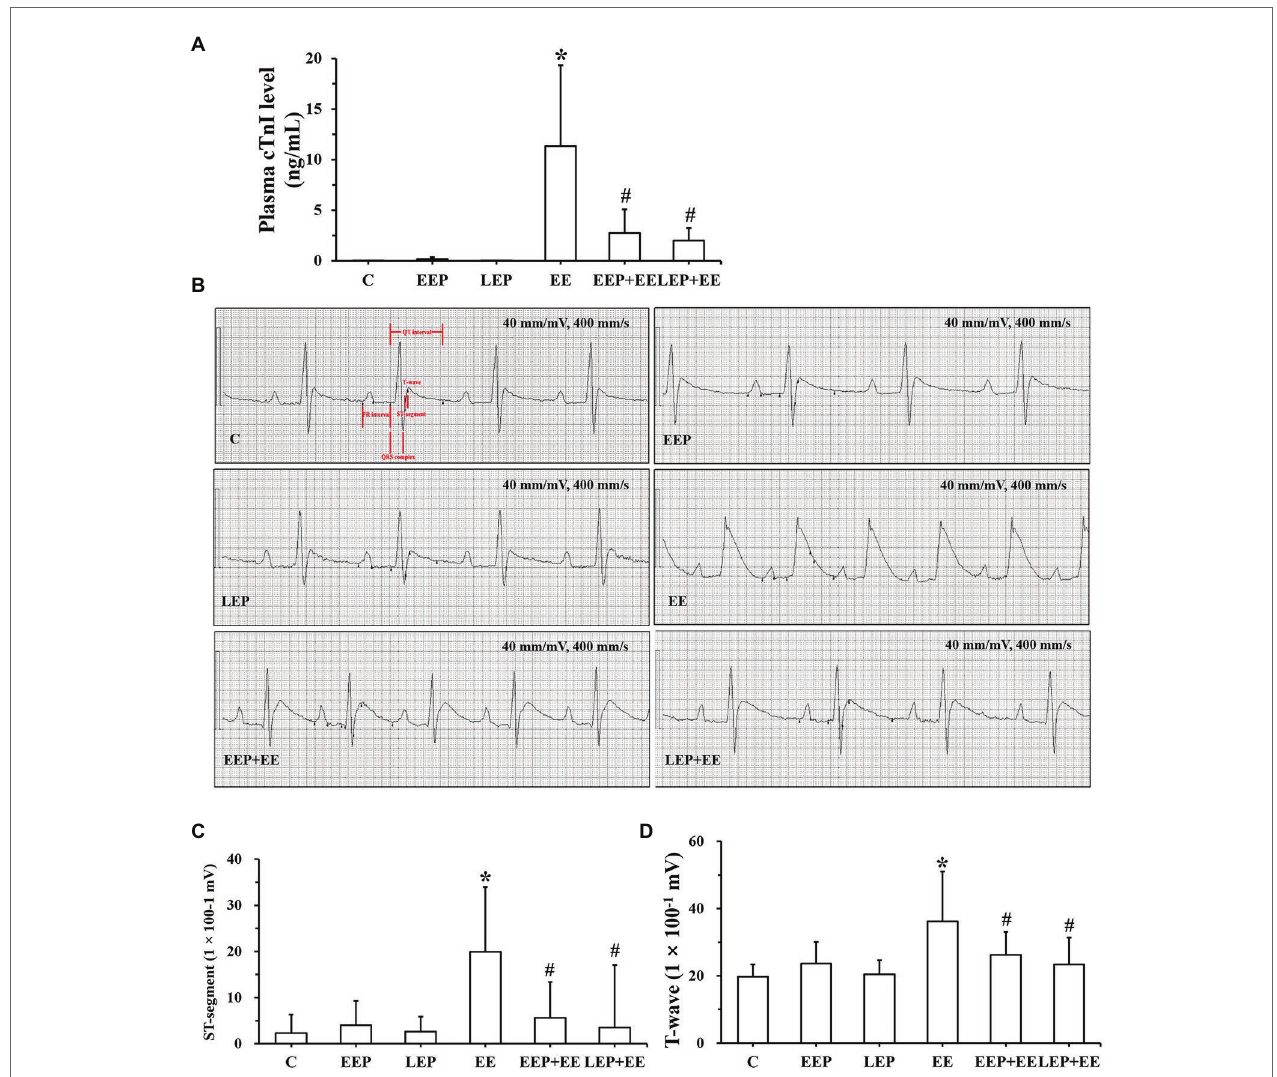
FIGURE 7 | Exercise preconditioning provided cardioprotection to alleviate exhaustive exercise-induced myocardial injury. (A) Alterations in plasma cardiac troponin I (cTnI) levels in different groups. (B) ECG signals. The ST-segments and T-waves from group C were normal. The ST-segments of group EE were obviously elevated and the T-waves were significantly higher in group EE. (C) Results of the ST-segments from ECGs. (D) Results of the T-waves from ECGs. * p < 0.05 vs. group C; # p < 0.05 vs. group